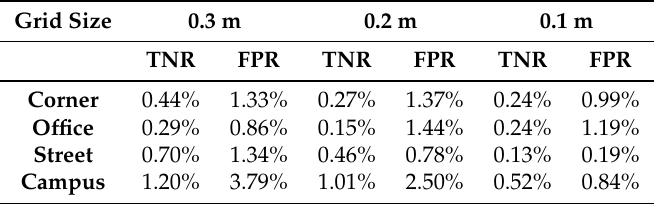
Table 2. The True Negative Rate (TNR) and False Positive Rate (FPR) of different datasets with respect to different grid